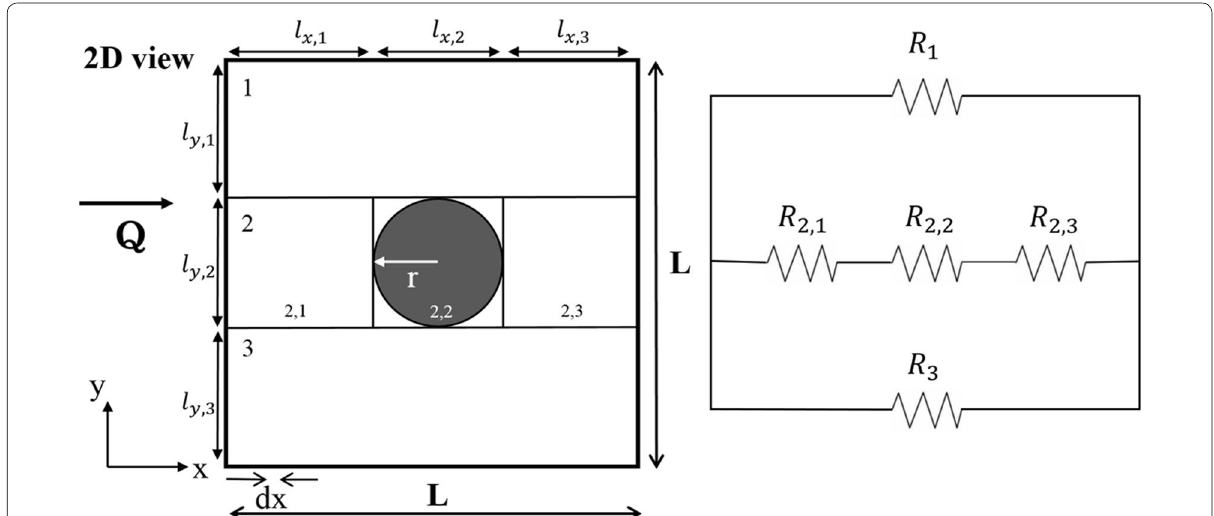
Fig. 3 2-dimensional view of reinforced concrete containing one round rebar and its thermal network.